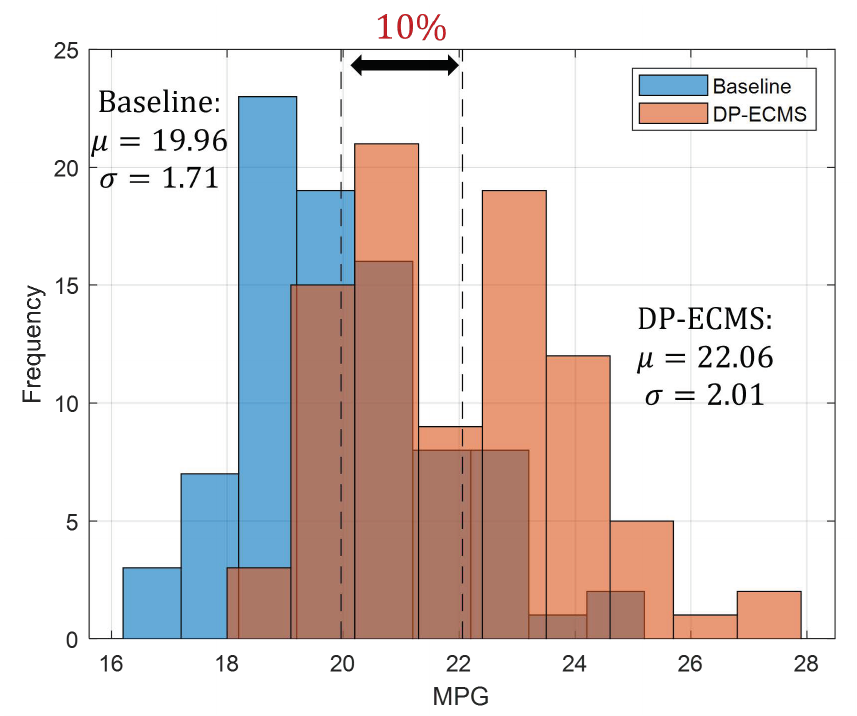
Figure 13. Fuel economy distribution of DP-ECMS and